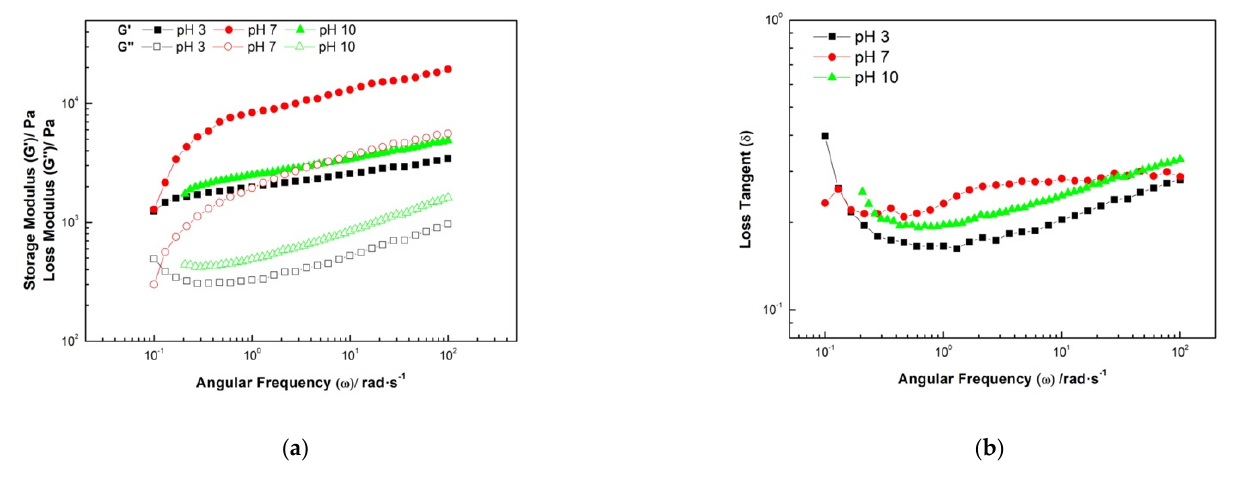
Figure 1. Dynamic rheology properties of hydrocolloids from butternut squash seeds at pH 3, 7, and 10. Frequency sweep ( a ) and loss tangent ( b ).